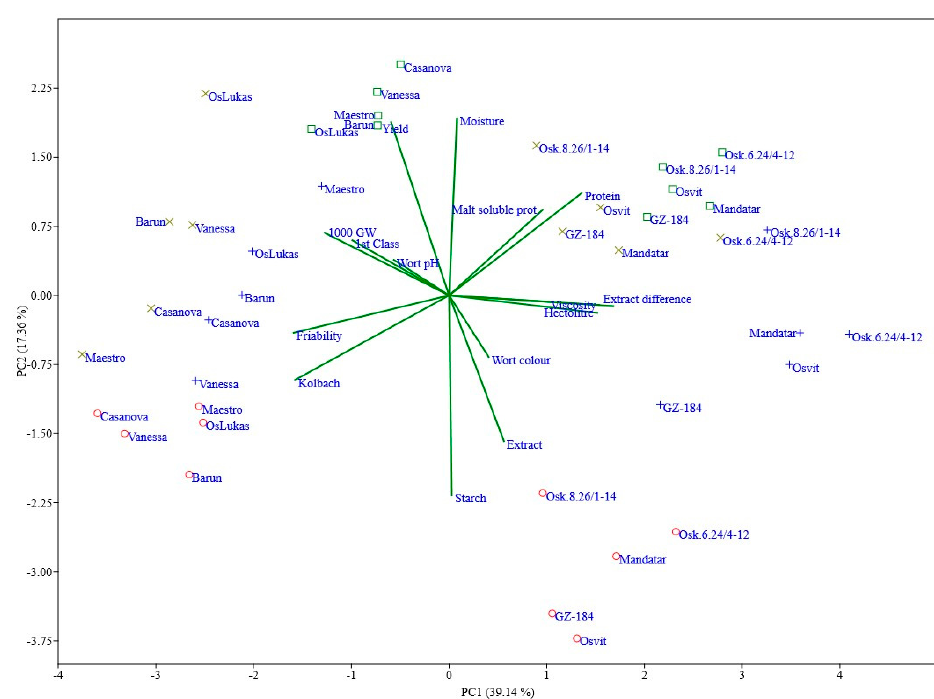
Figure 1. PCA bi-plot of ten winter barley varieties and their respective agronomic and quality traits observed through four growing seasons (2016—blue cross; 2017—green square; 2018—red circle; 2019—olive x).